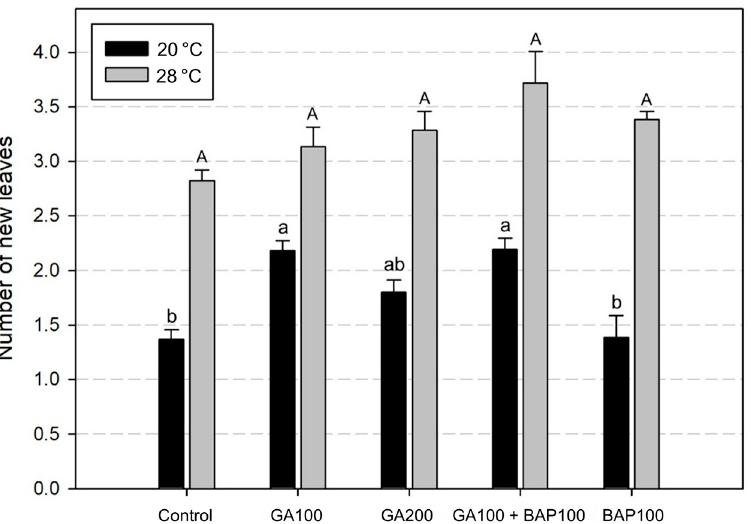
Figure 2. Number of new leaves of Phalaenopsis Queen Beer ‘Mantefon’ treated with exogenous gibberellic acid 3 (GA 3 ) and 6-benzylaminopurine (BAP) at either 28 °C (vegetative condition) or 20 °C (forcing condition) for 15 weeks. Control: no hormones; GA100: GA 3 100 mg/L; GA200: GA 3 200 mg/L; GA100 + BAP100: GA 3 100 mg/L + BAP 100 mg/L; BAP100: BAP 100 mg/L. Different letters above bars are considered significant at p < 0.05 by Tukey’s honestly significant difference (HSD) test.